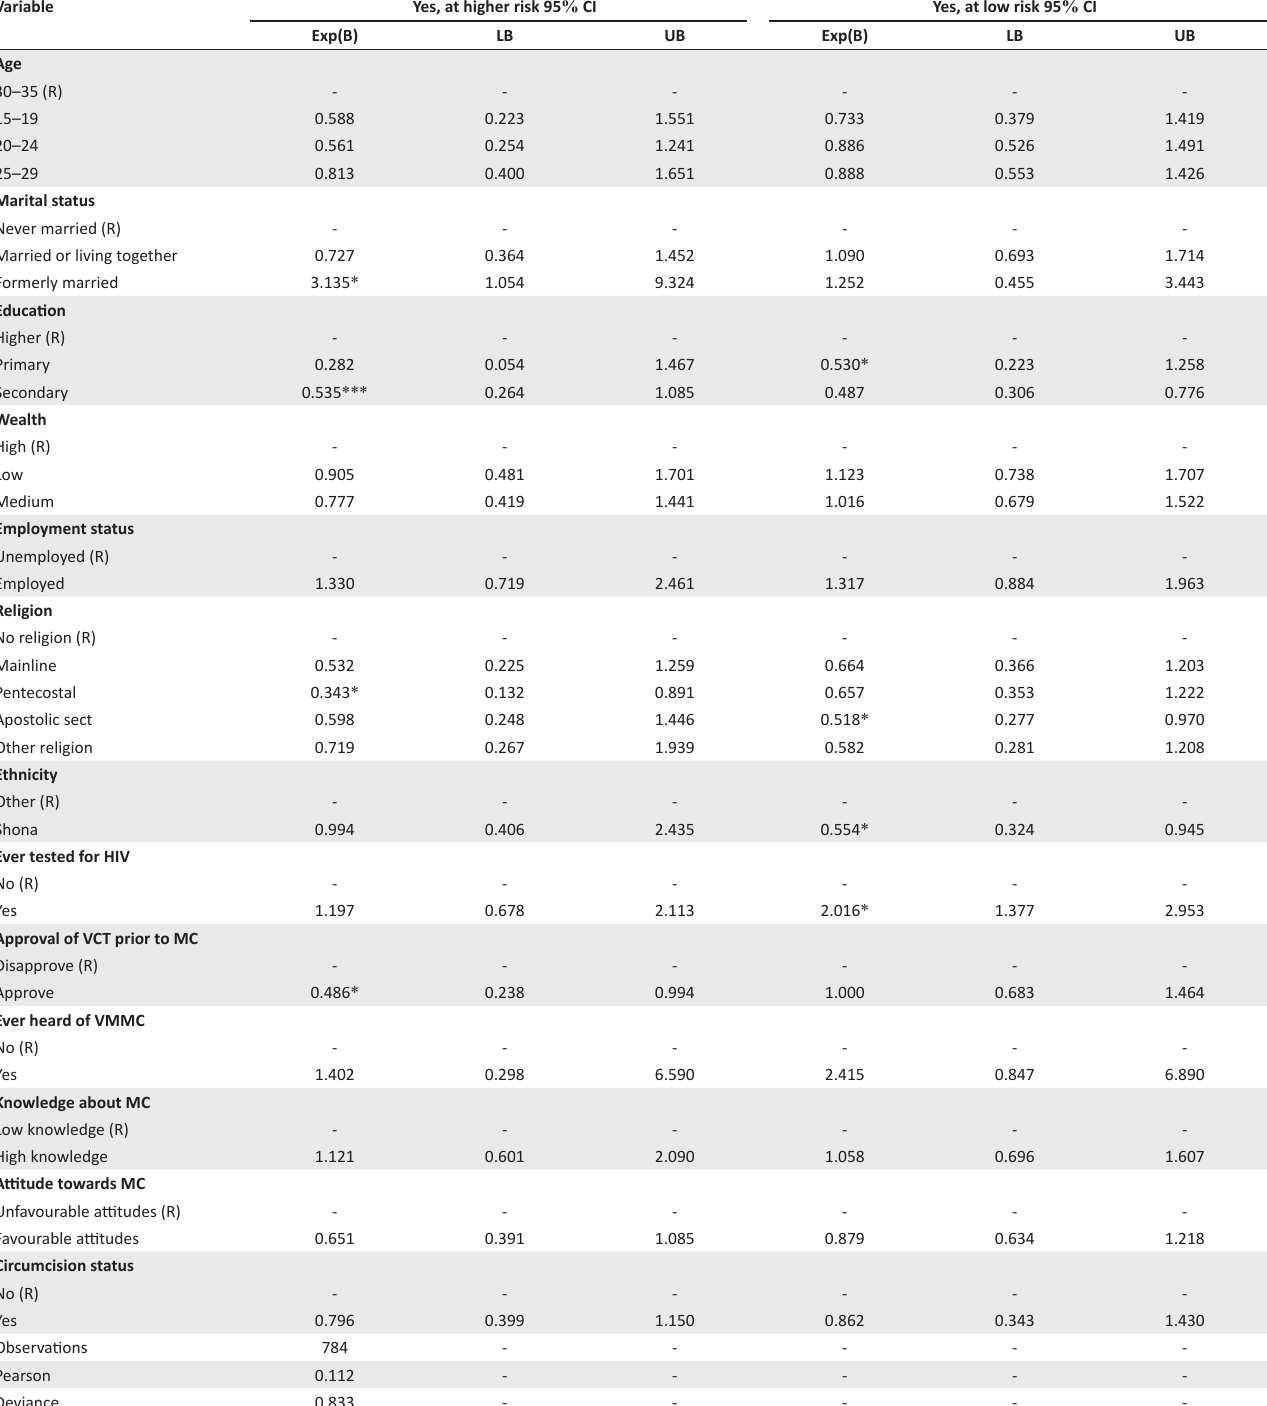
TABLE 7: Predictors of perception of risk of HIV infection.